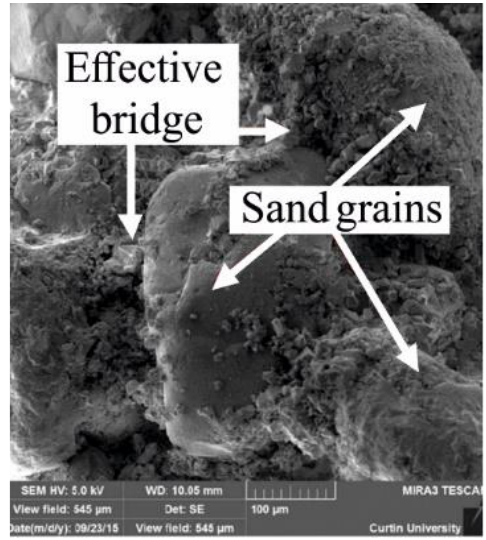
Figure 1. Carbonate joints between sand grains [53].